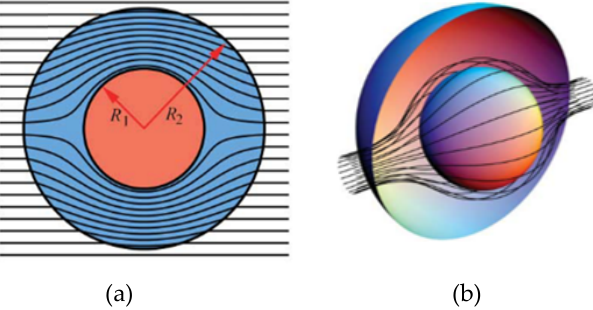
Figure 26. ( a ) Schematic diagram of a stealth cloak of 2D electromagnetic metamaterials; ( b ) Schematic diagram of a stealth cloak of 3D electromagnetic metamaterials [86] . diagram of a stealth cloak of 3D electromagnetic metamaterials [86].